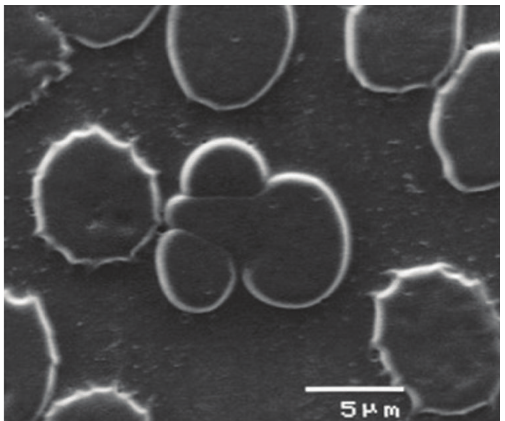
Figure 8: The magnification of one “incomplete” qRBC in blood film at SEM ( × 5000, 10